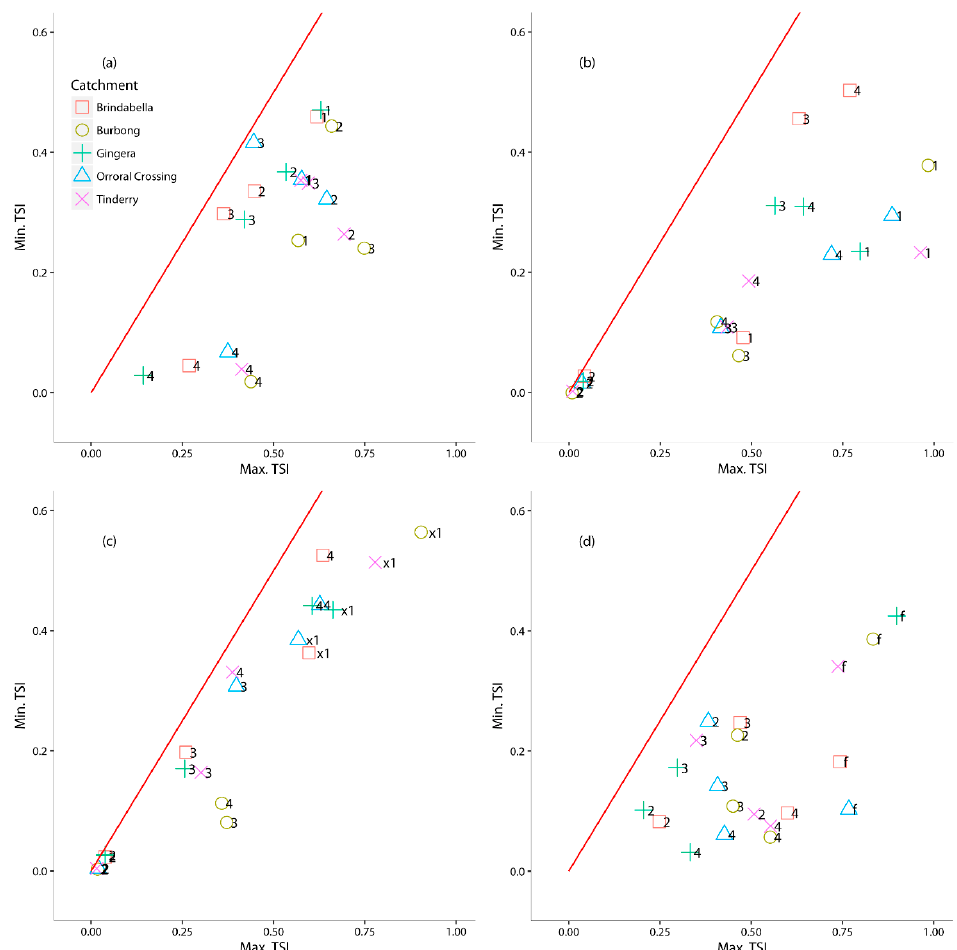
Figure 6. Sensitivity of the parameters of the four rainfall–runoff models for the five catchments to the NSE* target function: ( a ) result of the GR4J model, ( b ) IHACRES model, ( c ) GR_IH model (x1 is the parameter of the GR4J model), and ( d ) IH_GR model (f is the parameter of the IHACRES model). The one-to-one line is shown in red.